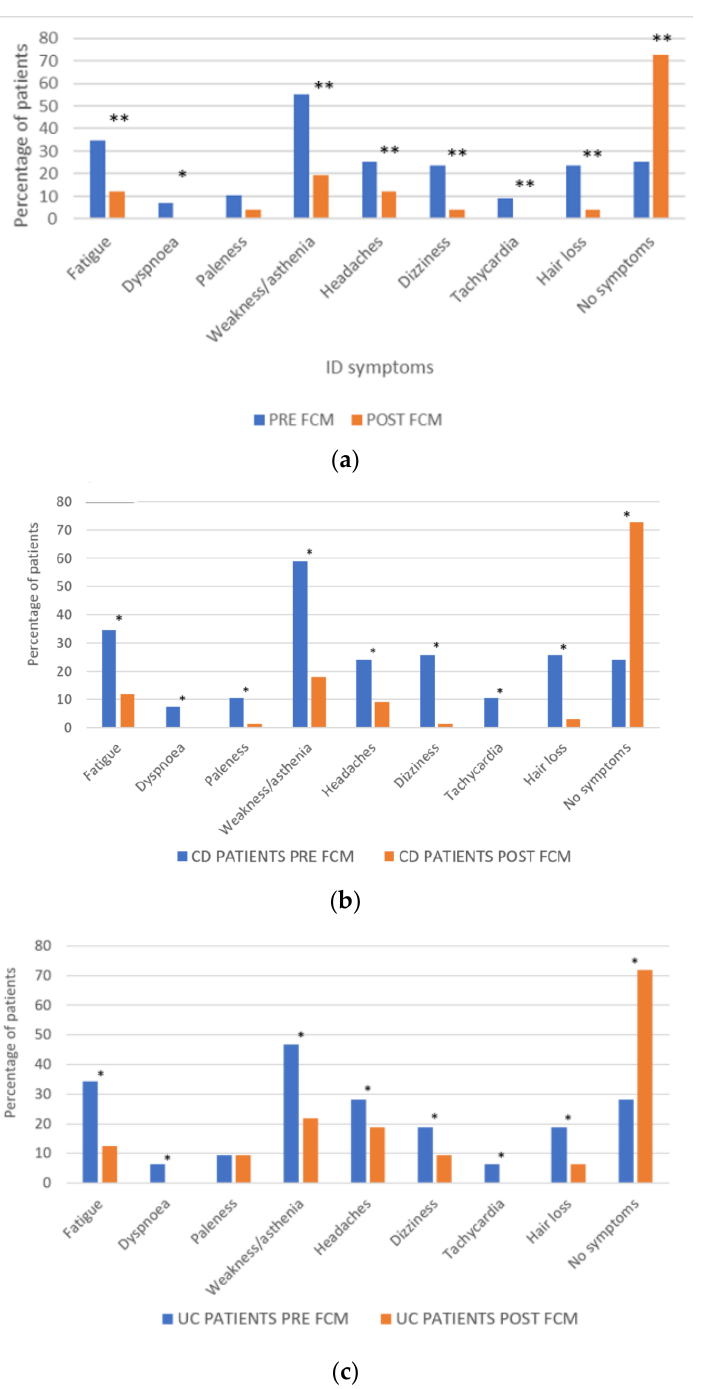
Figure 2. ( a ) Effect of FCM on self-reported ID symptoms; * p < 0.05; ** p < 0.01 (McNemar test). ( b ) Effect of FCM on ID symptoms patients with CD; * p < 0.05 (McNemar test) ( c ) and UC; * p < 0.05 (McNemar test).